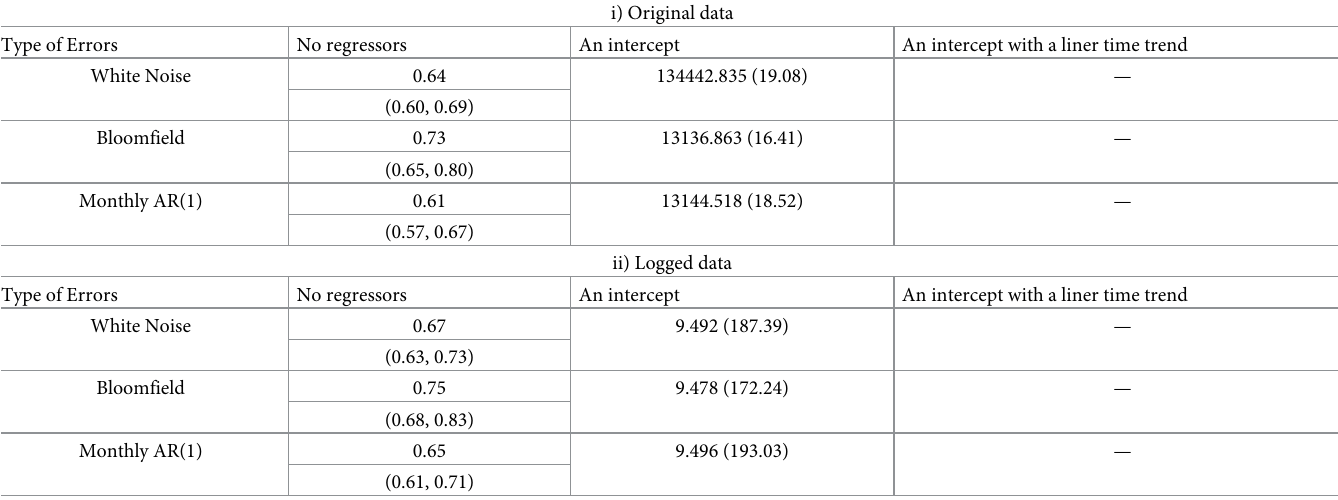
Table 4. Estimated coefficients for the selected models in Table 1: 1976m1 –